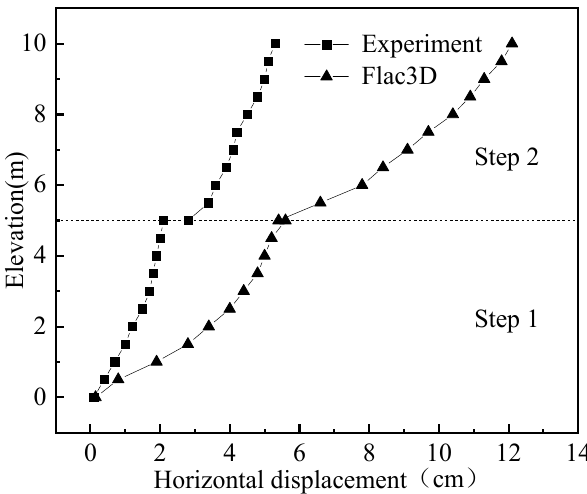
Figure 10. Comparison of horizontal displacements of panels.